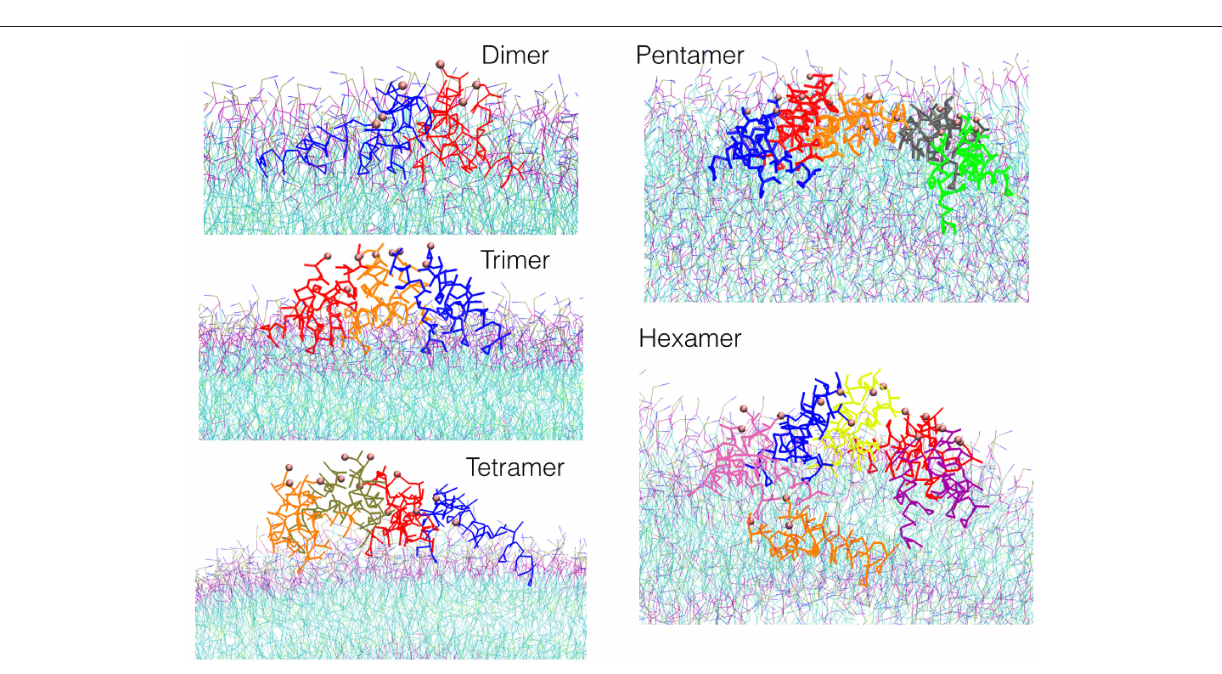
FIGURE 4 | Snapshots of the most representative structure for each oligomer found during the